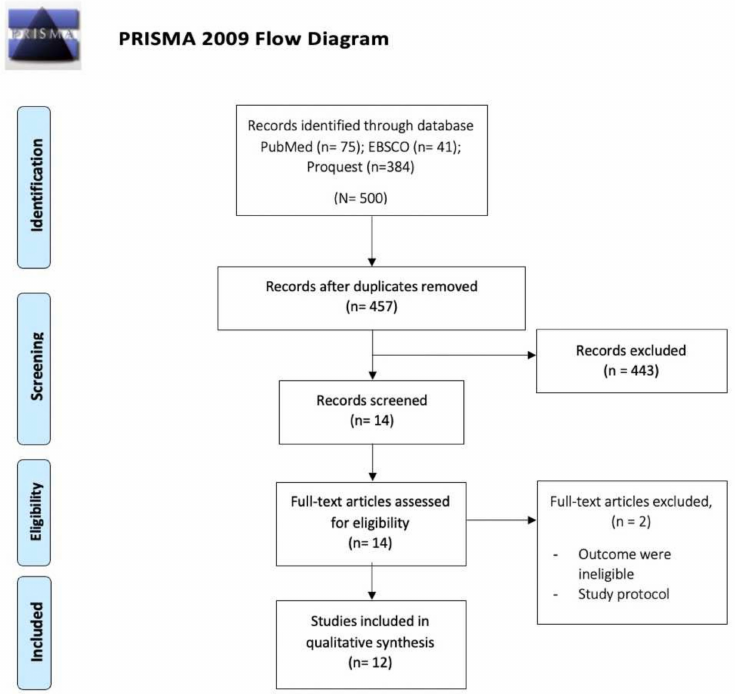
Figure 1. PRISMA flow diagram [21].